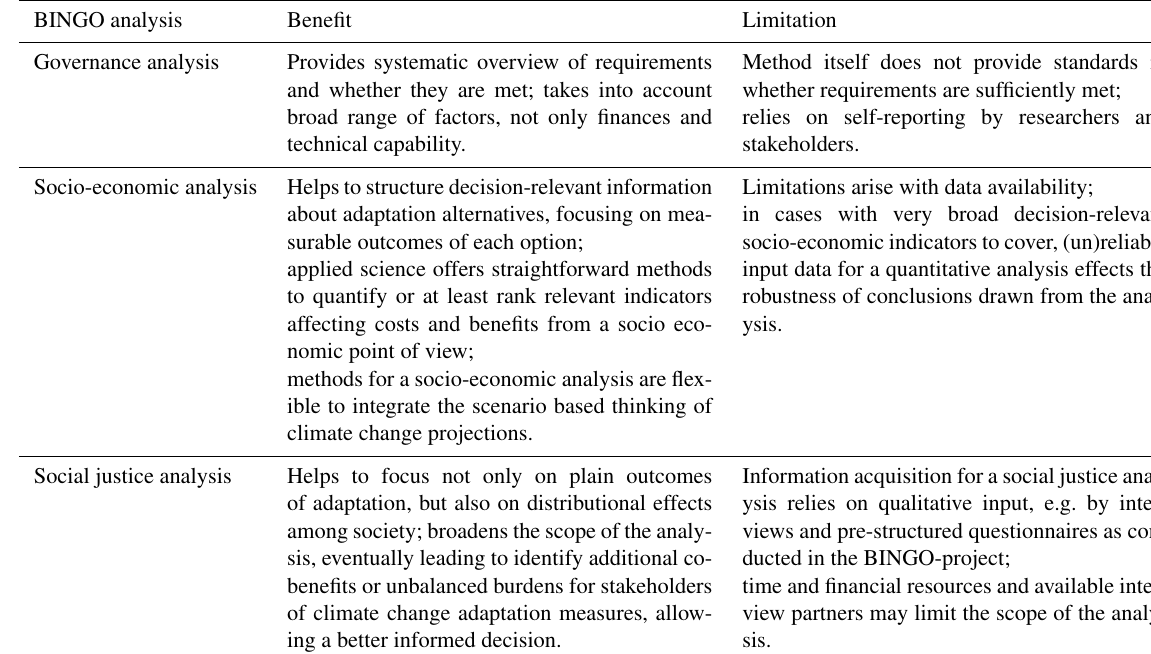
Table 2. Assessment of the applied